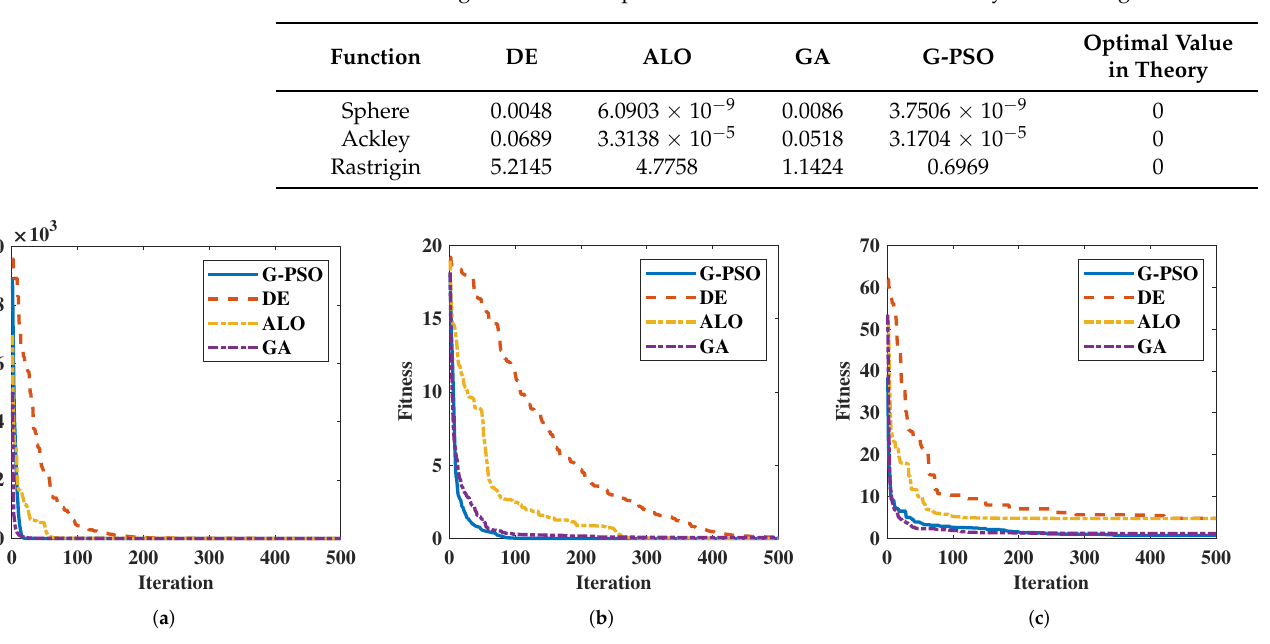
Figure 3. Average convergence curves:( a ) Convergence curves of Sphere function, ( b ) Convergence curves of Ackley function, ( c ) Convergence curves of Rastrigin